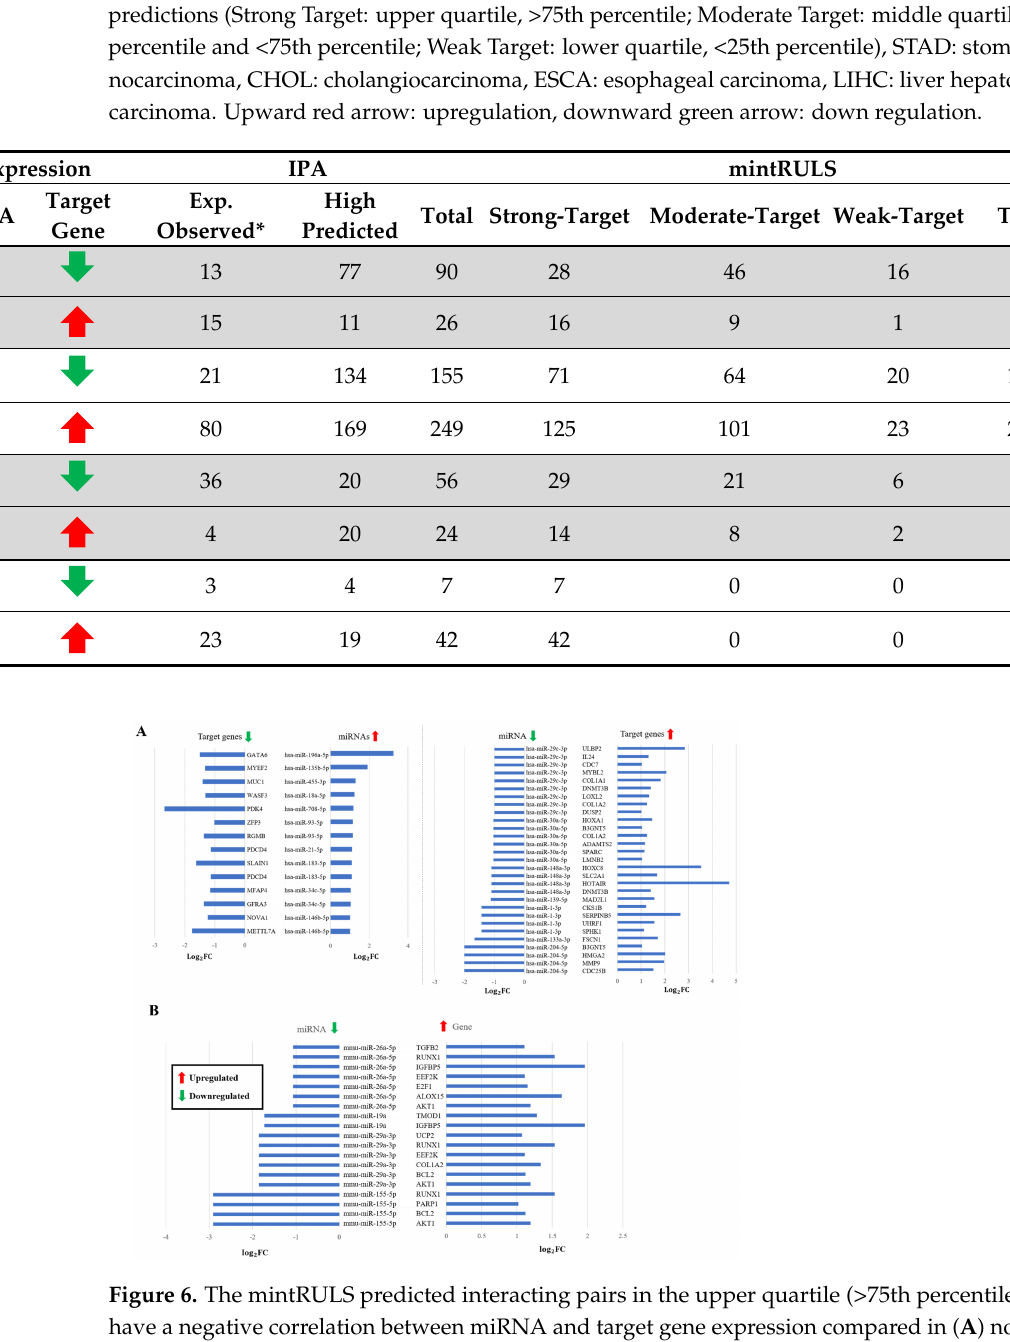
Table 5. The summary of miRNA–target gene pairs with opposite expression correlation of associated miRNA and target genes. The only pairs which showed “Experimental evidence” or “High prediction” in IPA analysis were selected. The corresponding columns also list pairs which were predicted as “Strong Target”, “Moderate Target”, and “Weak Target”. * All the miRNA-gene pairs which showed “Experimental evidence” in IPA were predicted as “Strong Target” in mintRULS. For detailed information, Supplementary Table S1 can be referred to. IPA: Ingenuity Pathway Analysis, mintRULS